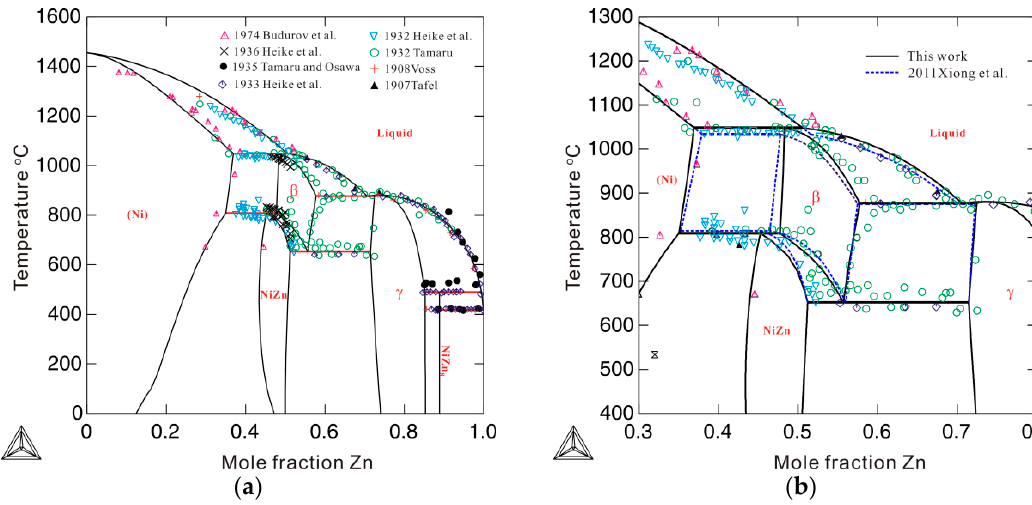
Figure 6. Calculated phase diagram of a binary Ni-Zn system according to the presently obtained thermodynamic descriptions, compared with the experimental data from Refs. [23–30]: ( a ) over the entire composition range and ( b ) from 30 to 80 at.% Zn. The blue dashed lines are the phase boundaries related to the β phase calculated by Xiong et al. [11]. Table 2. List of the invariant reactions related to the β phase, calculated according to the presently obtained thermodynamic parameters, compared to the literature data [11,25,26,28].